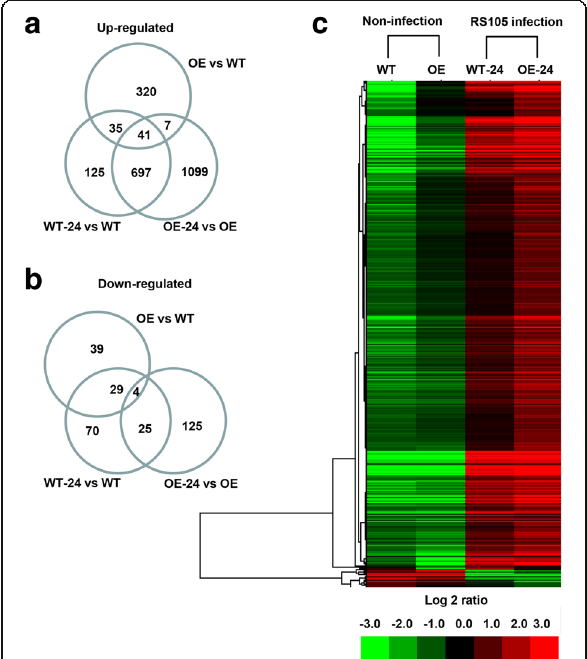
Fig. 5 Gene expression profiling by RNA-seq. a Statistics for up- regulated genes among OE vs WT, WT-24 vs WT, and OE-24 vs OE. b Statistics for down-regulated genes. c Hierarchical clustering of differentially expressed genes. Total RNA was purified from non- infected and infected leaves (24 h post inoculation) of Shengdao 806 (WT) and CD39R-7 (OE). RNA-seq was performed on BGISEQ- 500 by Beijing Genomic Institution. Differentially expressed genes were defined according to the combination of the absolute value of log2-Ratio ≥ 1 and FDR ≤